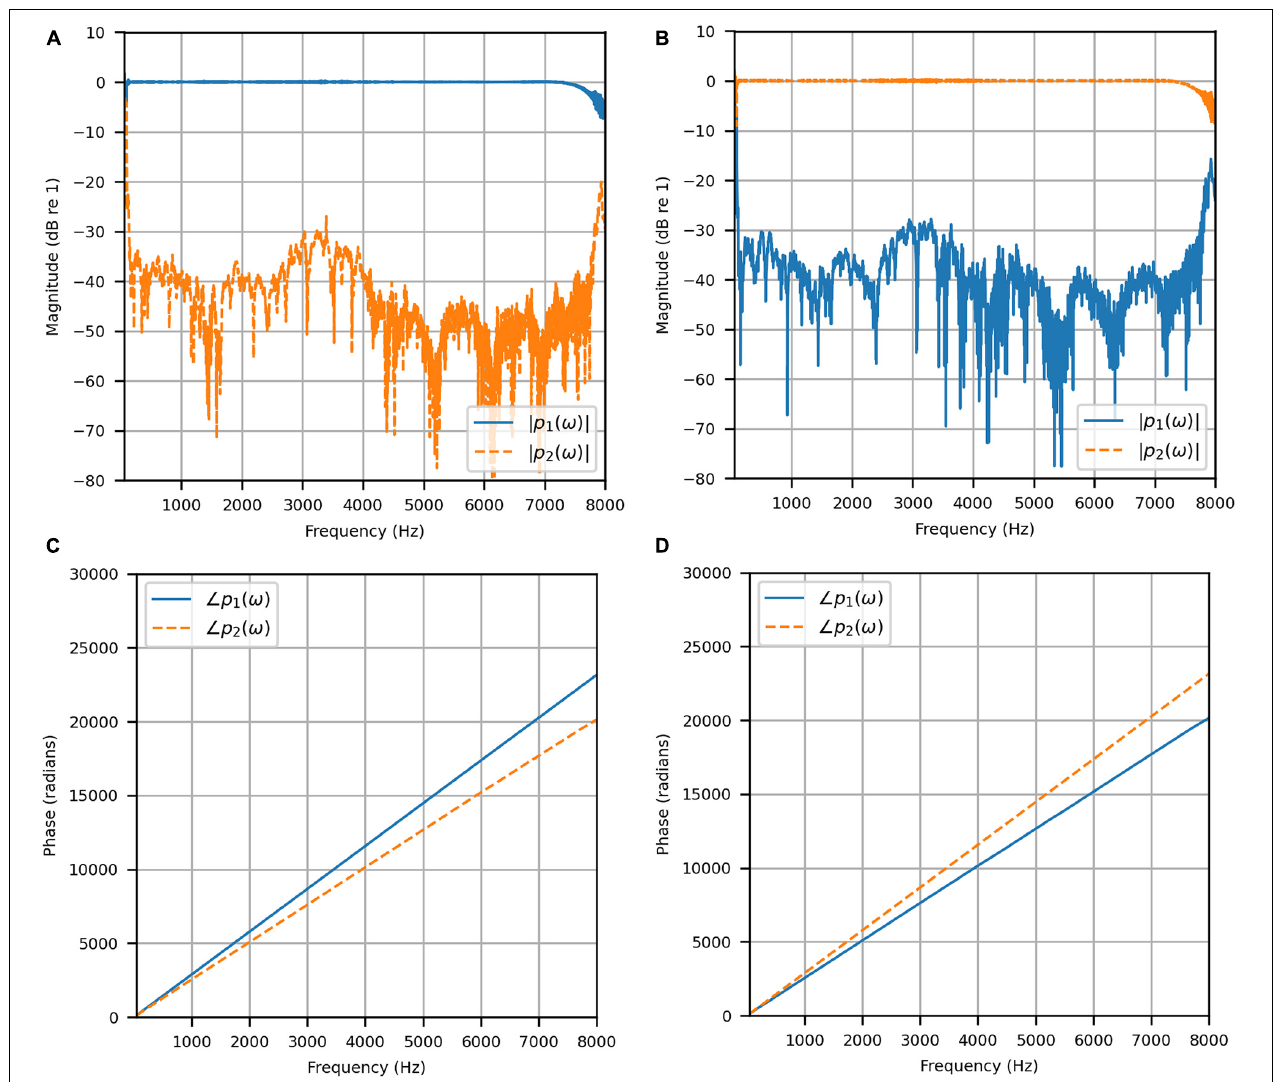
FIGURE 9 | Clinical booth: (A) Reproduced magnitude responses for a target impulse to the left microphone (blue solid); (B) Reproduced magnitude responses for a target impulse to the right microphone (red dashed); (C) Reproduced phase responses for a target impulse to the left microphone (blue solid); (D) Reproduced phase responses for a target impulse to the right microphone (red